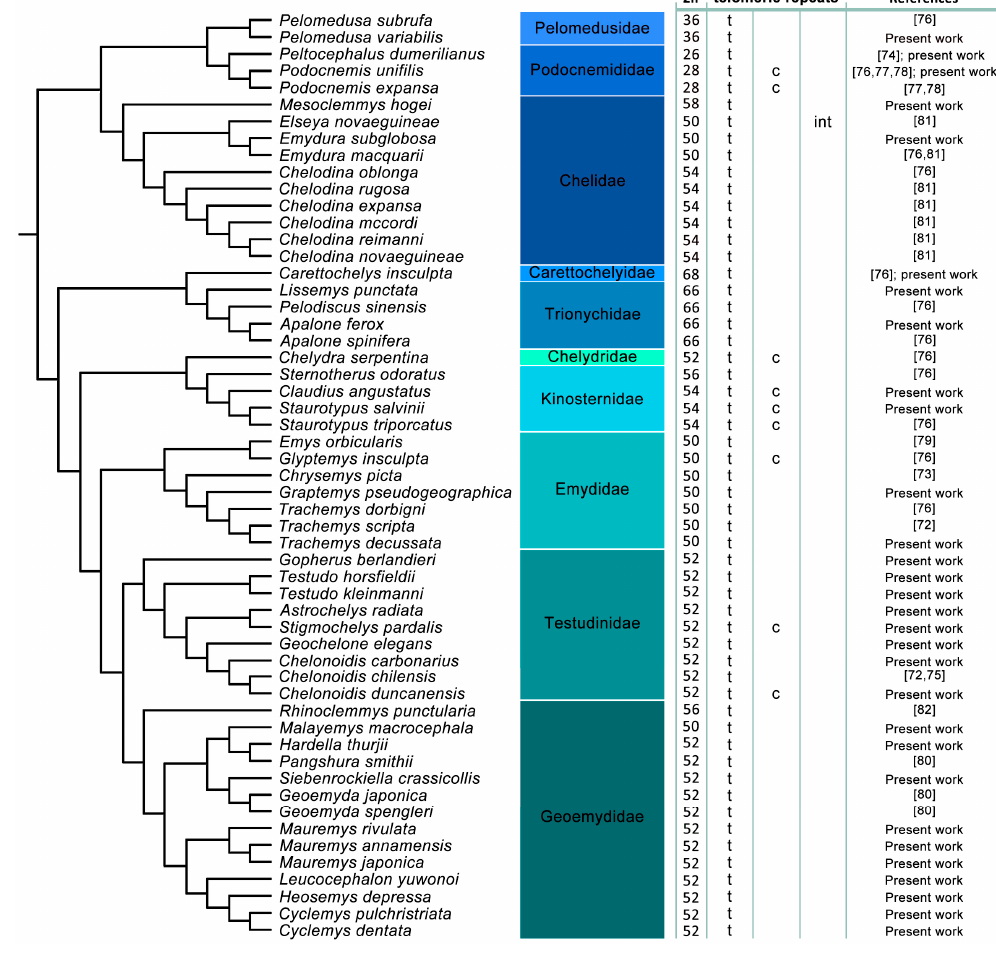
Figure 1. Distribution of the presence of telomeric repeats across turtles. Telomeric repeats were detected in terminal topology (t) in all studied species of turtles, and additionally, interstitial telomeric repeats (ITRs) were identified in centromeric (c) (9 species) and intermediate (int) (1 species) positions.